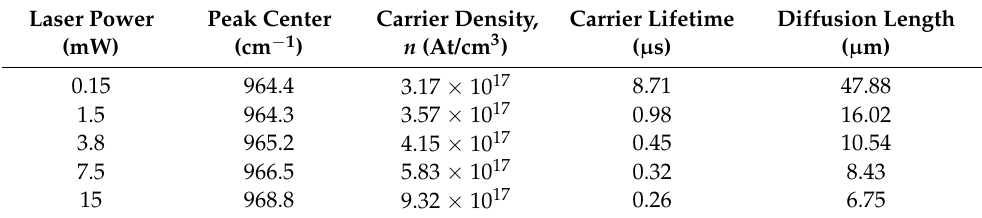
Figure 4. Plot of the Raman shift as a function of laser power. Table 1. LO Raman Shift, carrier density, carrier lifetime and diffusion length as a function of laser power.